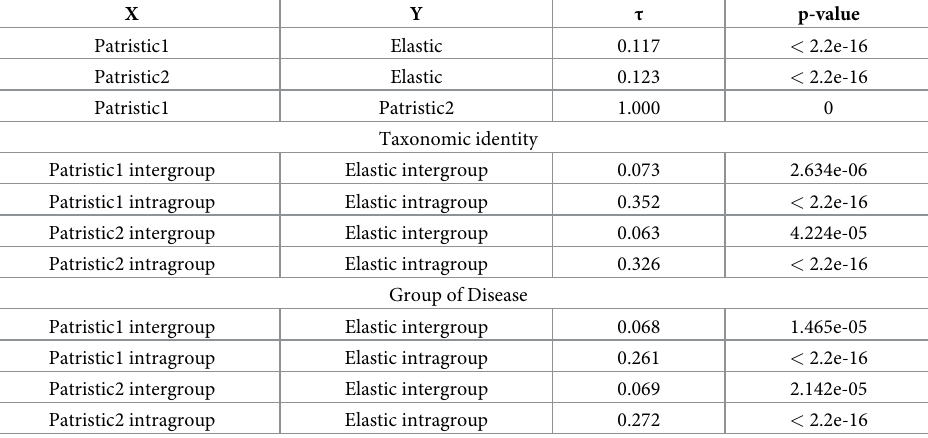
Table 2. Kendall correlation coefficient τ for different distance metrics within and between coronavirus